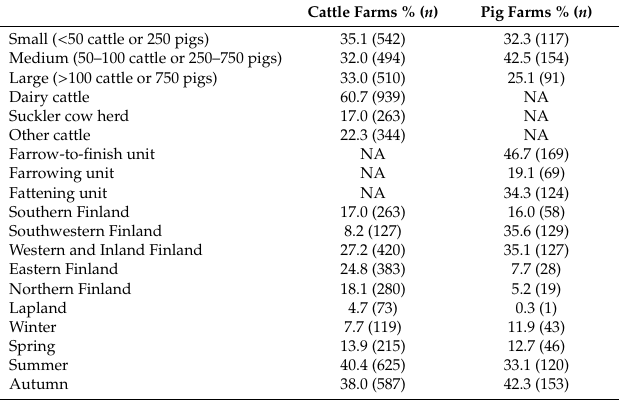
Table 4. Descriptive information for inspected farms and inspection season divided by farm